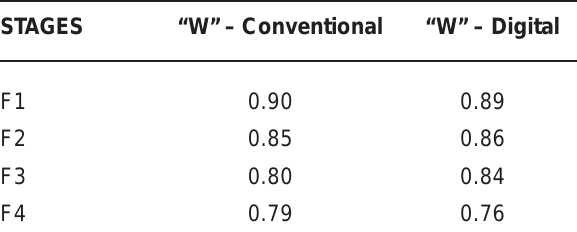
TABLE 1 - Kendall’s coefficient of concordance (“W”) for inter-examiner STAGES